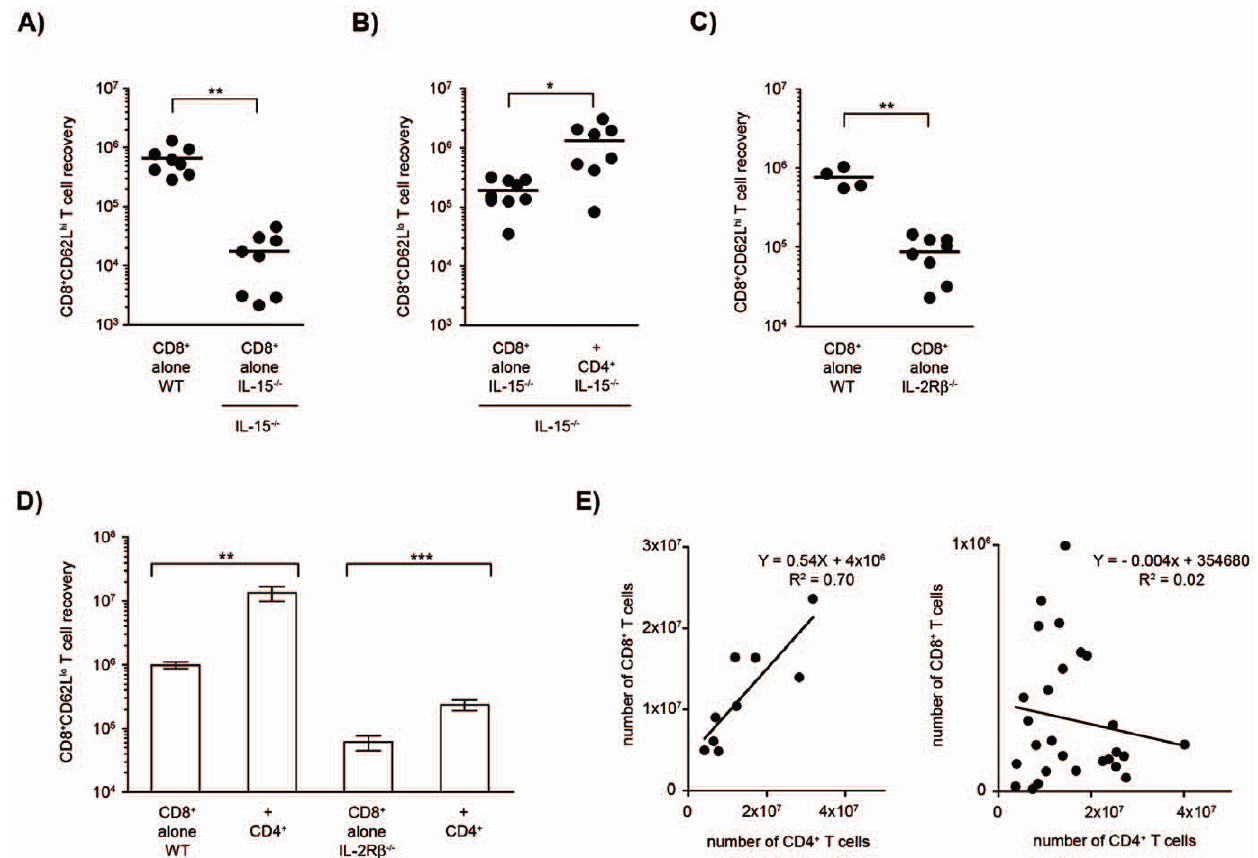
Figure 7. Role of IL-15 in the CD4 + -dependent accumulation of CD8 + T cells. ( A ) The number of CD8 + CD62L high T cells recovered in Rag 2 / 2 and in Rag 2 / 2 IL-15 2 / 2 hosts after 2 6 10 4 naı¨ve CD8 + T cells from WT or IL-15 2 / 2 mice were transferred alone or with CD4 + T cells into immune- deficient WT or IL-15 2 / 2 hosts. ( B ) 2 6 10 4 naı¨ve CD8 + T cells from IL-15 2 / 2 mice were transferred alone or with IL-15 2 / 2 CD4 + T cells into immune- deficient IL-15 2 / 2 hosts. The CD8 + CD62L low T cell recovery after 4 weeks is shown for two pooled experiments. In the complete absence of IL-15, we observed an increased accumulation of the CD8 + (CD62L low ) T cells in presence of the CD4 + T cells. Statistically significant differences are shown (* p # 0.05; ** p , 0.01). ( C ) The CD8 + CD62L high T CM cell recovery 7 weeks after transferring 2 6 10 4 naı¨ve CD8 + T cells from WT or IL-2R b 2 / 2 donors alone into immune-deficient mice. Similar results were obtained in three independent experiments (** p # 0.01). ( D ) 2 6 10 4 naı¨ve CD8 + T cells from WT (left) or IL-2R b 2 / 2 donors (right) were injected alone or with 2 6 10 4 CD4 + T cells into immune-deficient hosts. The bars indicate the mean 6 se of CD8 + T EM cell recovery after 8–9 weeks from four pooled experiments (n=20–24) (** p # 0.01; *** p , 0.001). ( E ) Correlation of the number of WT (left) or IL-2R b 2 / 2 (right) CD8 + T cells and WT CD4 + T cells recovered in individual hosts. The correlation coefficients are shown (p , 0.0001 and NS